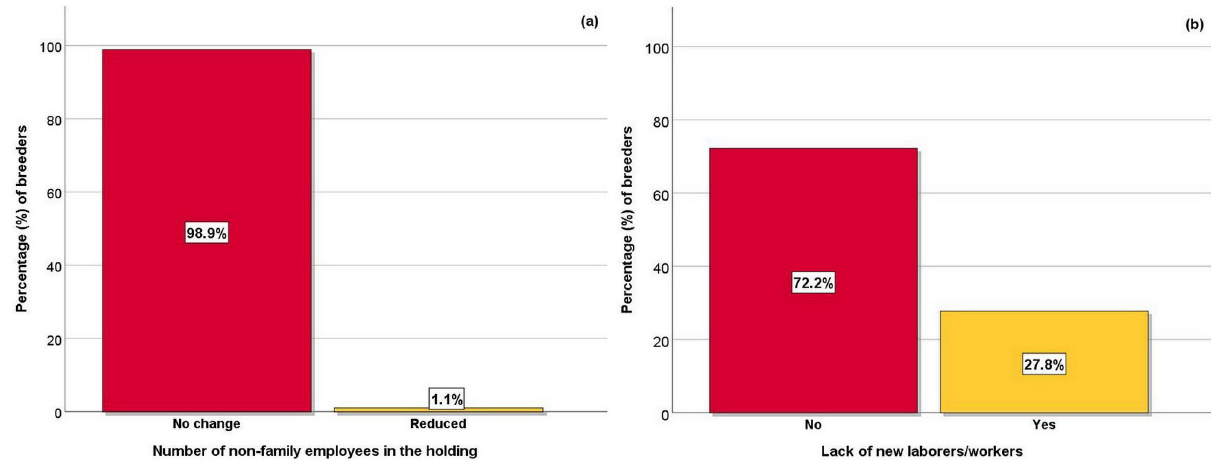
Figure 5. Effect of COVID-19 restrictive measures on the (a) number of non-family employees and (b) lack of laborers and/or workers.